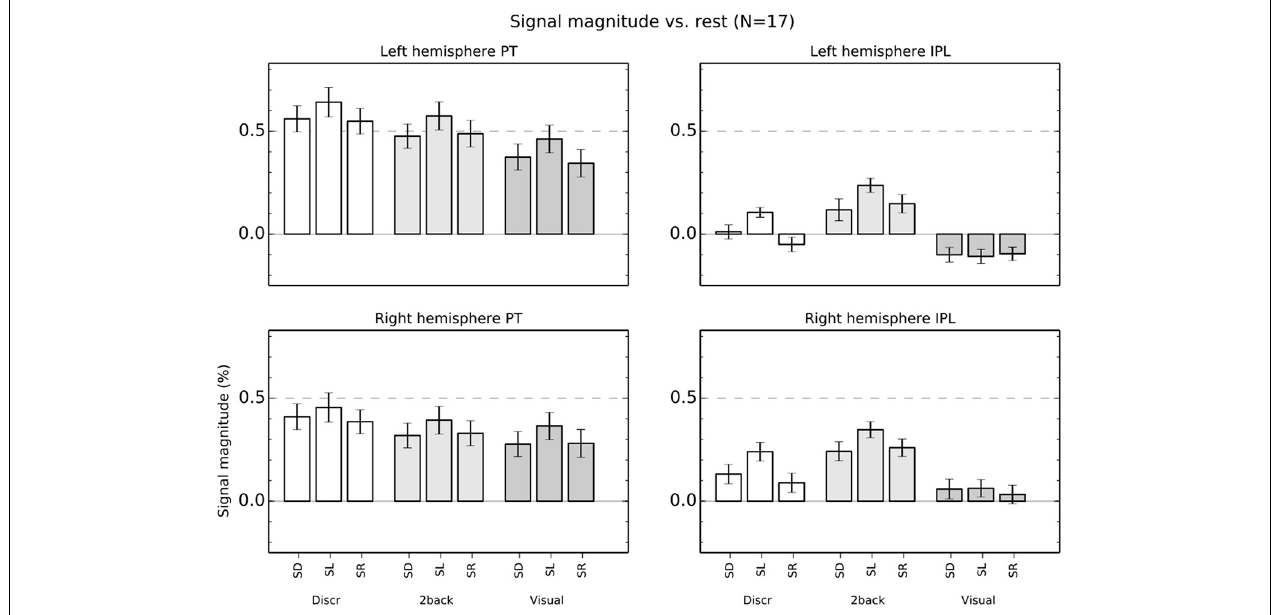
FIGURE 6 | Percentage signal magnitude in left and right hemisphere planum temporale (PT) and IPL ROIs (see Figure 2D). The bars show mean ( ± s.e.m.) ROI signal relative to